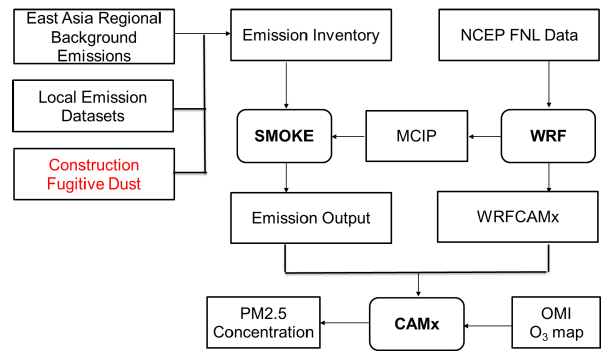
Figure 1. Framework of the WRF-SMOKE-CAMx model system in Xi’an. The Ozone Monitoring Instrument (OMI) O 3 map pre- pares ozone column input files for CAMx in order to improve the photolysis rate calculation. CAMx forecasted the air pollutant for the next 48h.